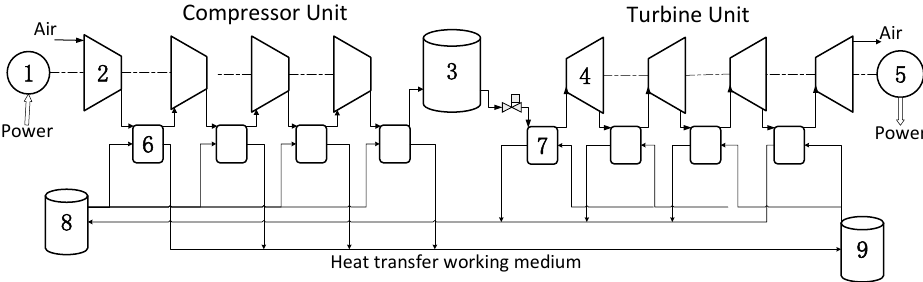
Figure 1. Advanced adiabatic compressed-air energy storage system.